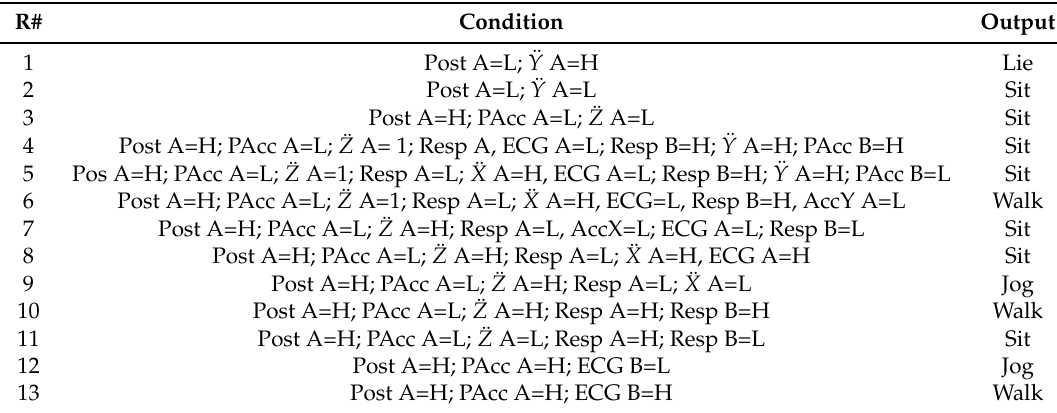
Table 5. Final rule set based on the C4.5 algorithm.